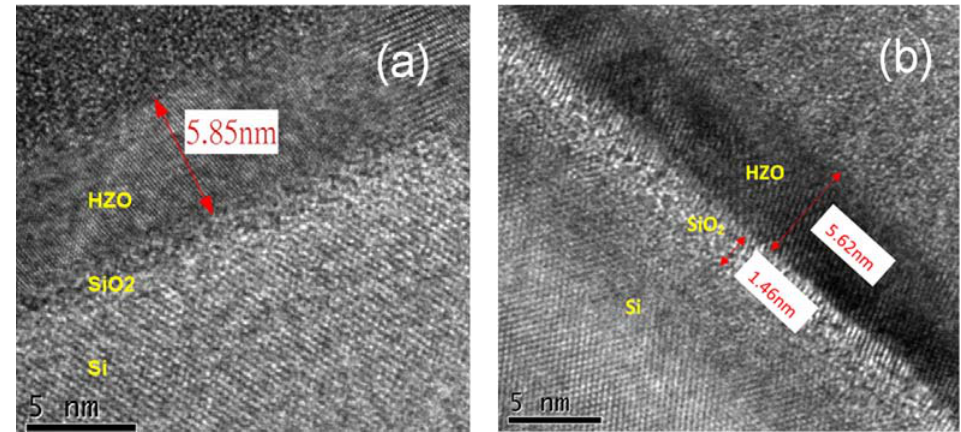
Figure 6. HRTEM of gate stack for Fe - FinFET ( a ) before and ( b ) after hot carrier stress.